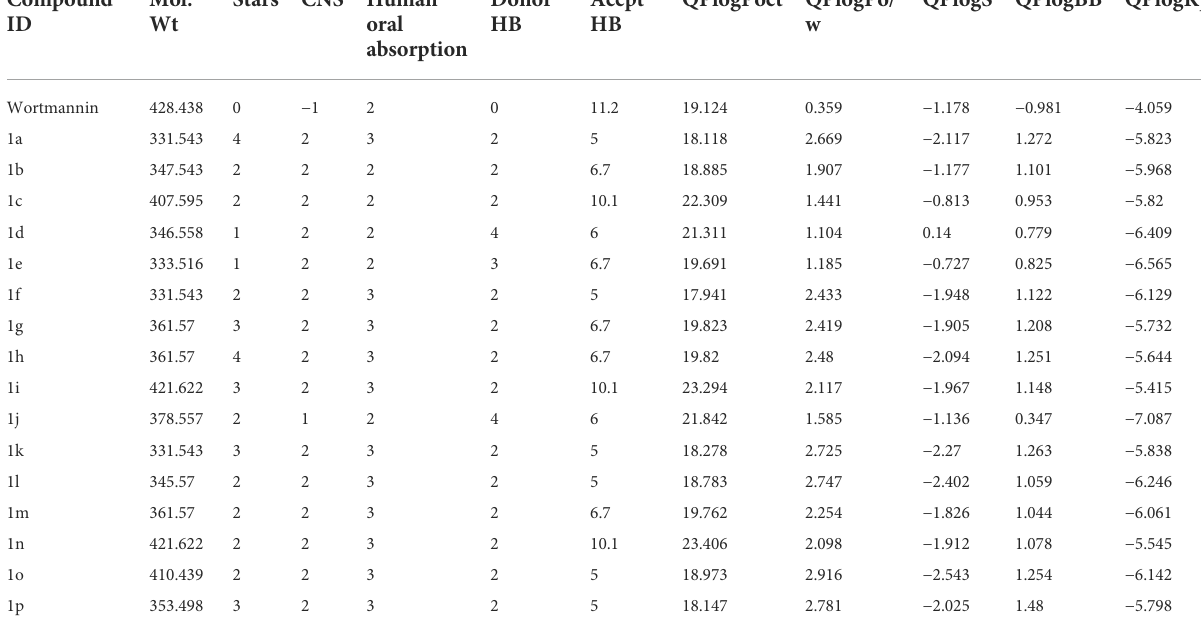
TABLE 4 ADME properties of the reference and the hit compounds.